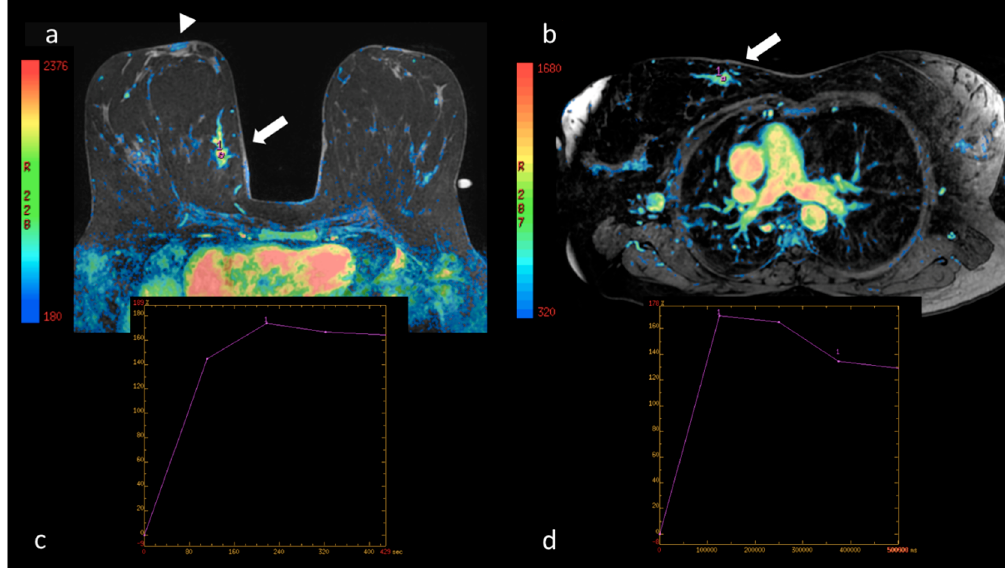
Figure 6. ( a ) Native image of the first dynamic sequence performed in the prone position superimposed with the colorimetric map showing maximum contrast impregnation (see the reference side bar) in the nipple area (arrowhead). At the confluence of the internal quadrants of the right breast, the site of the neoplasia described in Figure 4, the distribution of the contrast medium is shown (arrow); in the area of maximum impregnation a region of interest (ROI) has been drawn marked by the number 1. The corresponding percentage/time intensity curve (au/sec) is shown in ( c ). ( b ) Native image of the first dynamic sequence performed in the supine position superimposed with the colorimetric map. In this position, the dynamic curve of the breast lesion was evaluated in a ROI marked by the number 1. The corresponding percentage/time intensity curve (au/sec) is shown in ( d ). In both positions the curve is a type III with the same maximum peak values in the early phase; in ( d ) the late-phase wash-out appears more accentuated.